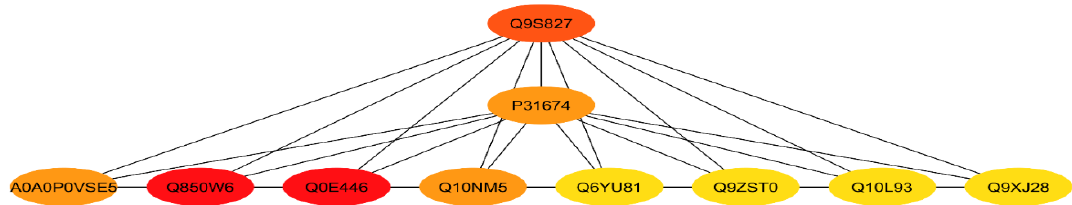
Figure 7. The hub-proteins selected from the total DEPs of WT and GN-5. Every node represents proteins and the edges indicate connections between the nodes, the red color denotes the higher co- expression.